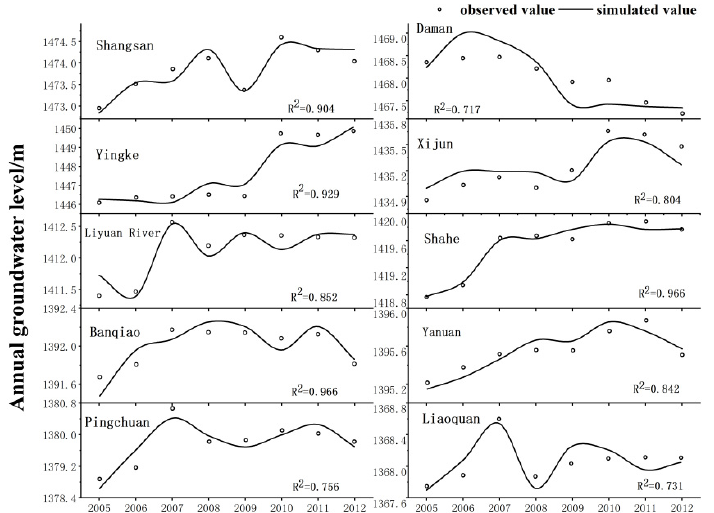
Figure 9. Simulation of groundwater level in the middle reaches of the Heihe River from Yingluo Gorge to Pingchuan River.